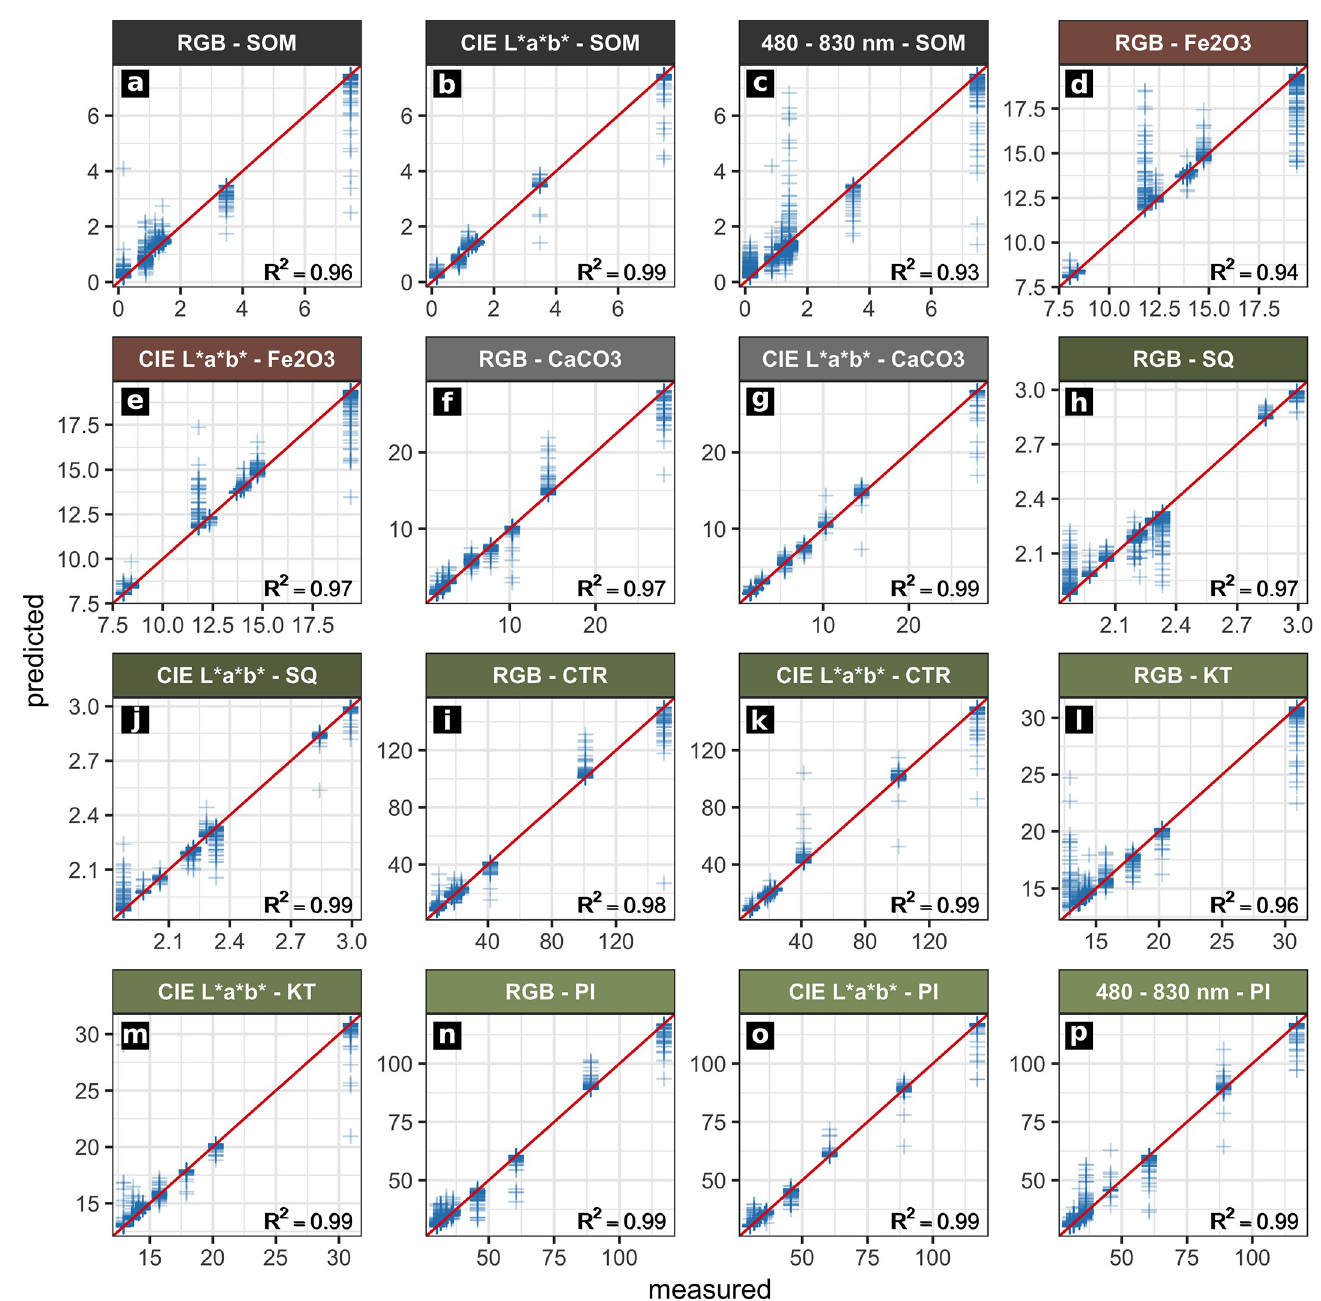
Fig 5. Results from regression analyses of profile EVI. Actual (measured) and predicted values of the sediment properties examined. The ideal performance is shown by the red line (y = x). Only models with a cross-validated R 2 greater than 0.8 and a high correlation between the respective prediction map and the stratigraphic delineation are